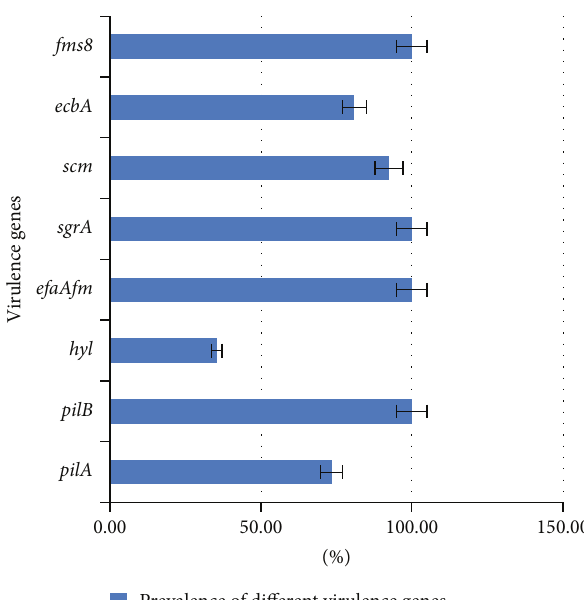
Figure 1: Prevalence of different virulence genes in clinical E. faecium and E. faecalis isolates. The pilB, fms8, efaAfm, and sgrA were identified in all clinical